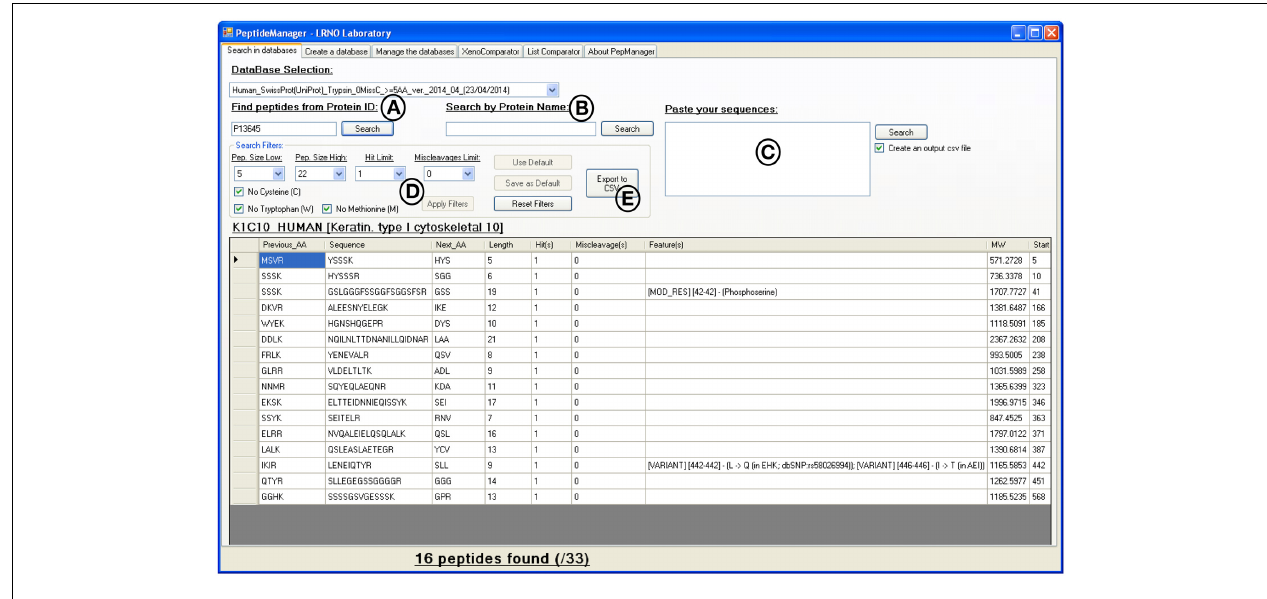
FIGURE 3 | Print screen of the results displayed by PeptideManager for the P13645 human protein. Search queries can be performed by protein ID (A), by protein name (B) or by peptide sequence(s) (C). The list of peptides obtained can be filtered out according to the length (e.g., 5 a.a. ≤ peptide